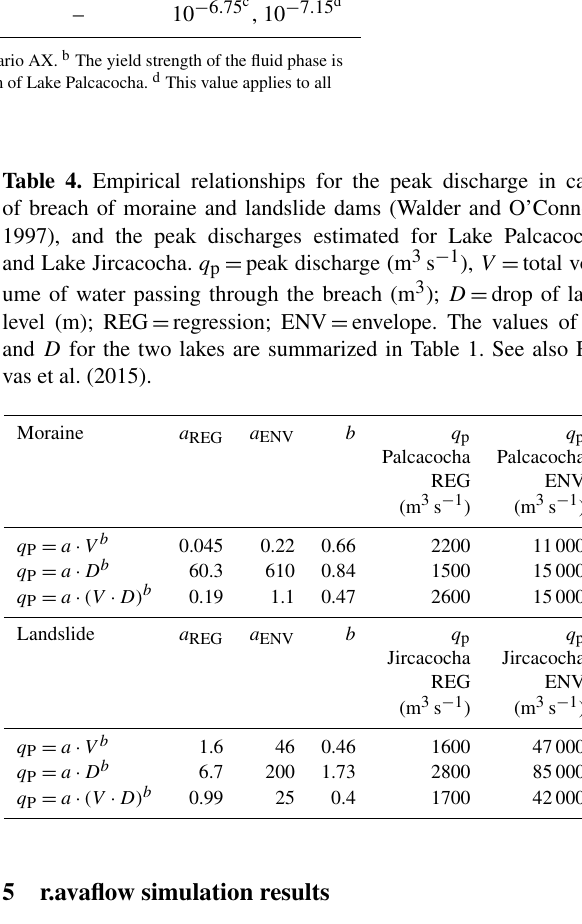
Table 3. Key model parameters applied to the simulations in the present work. Where three values are given, the first value applies to the glacier, the second value to the remaining area upstream of the dam of Lake Jircacocha, and the third value to the area downstream of the dam of Lake Jircacocha. Symbol Parameter Unit Value ρ S Solid material density (grain density) kgm − 3 2700 ρ F Fluid material density kgm − 3 1000 a ϕ Internal friction angle Degree 28 δ Basal friction angle Degree 6, 12, 7 ν Kinematic viscosity of fluid m 2 s − 1 ∼ 0 τ y Yield strength of fluid Pa 0 b C AD Ambient drag coefficient – 0.02, 0.005, 0.005 C FF Fluid friction coefficient – 0.001, 0.004, 0.004 C E Entrainment coefficient – 10 − 6 . 75 c , 10 − 7 . 15 d a The fluid material density is set to 1100kgm − 3 in Scenario AX. b The yield strength of the fluid phase is set to 5Pa in Scenario AX. c This value applies to the dam of Lake Palcacocha. d This value applies to all other areas.